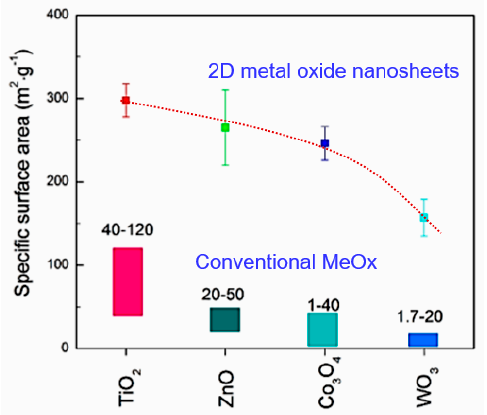
Figure 37. Typical specific surface areas of conventional metal oxide nanoparticles and 2D metal oxide nanosheets. Reproduced from Sun et al. [335]. Published by Nature Research as open